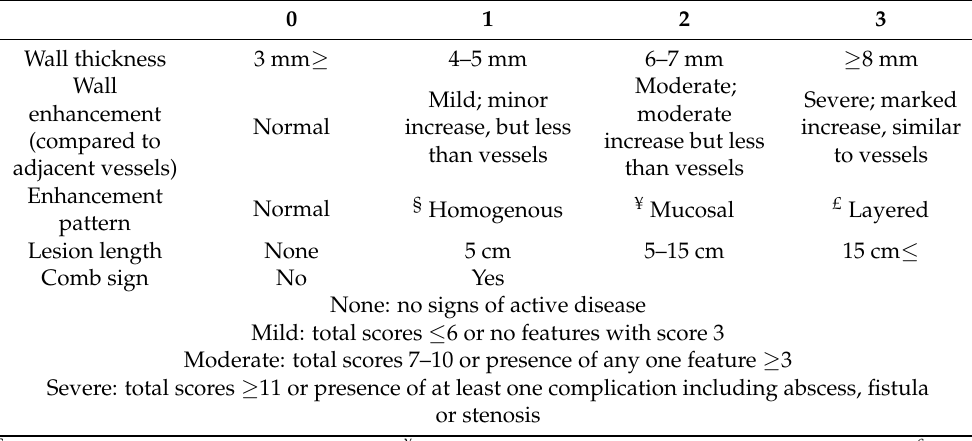
Table 1. Modified CT scoring